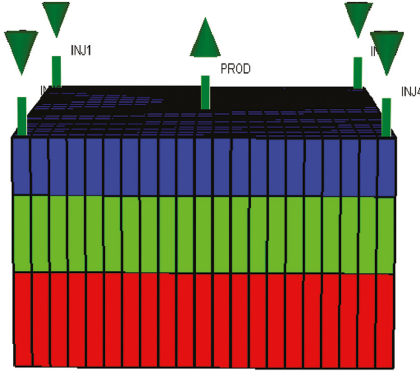
Figure 7: Three-dimensional geological